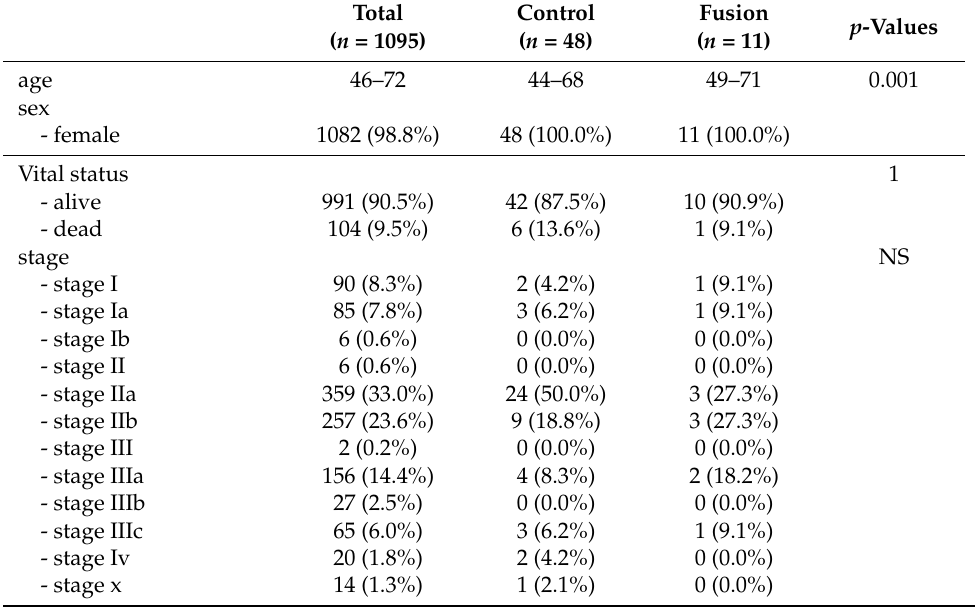
Table 1. Comparisons in clinical and pathological characteristics of ESR1-CCDC170 fusion-positive and negative BRCA patients and control cohorts. The clinical and pathological characteristics between ESR1-CCDC170 fusion-positive, negative BRCA, and control cohorts were